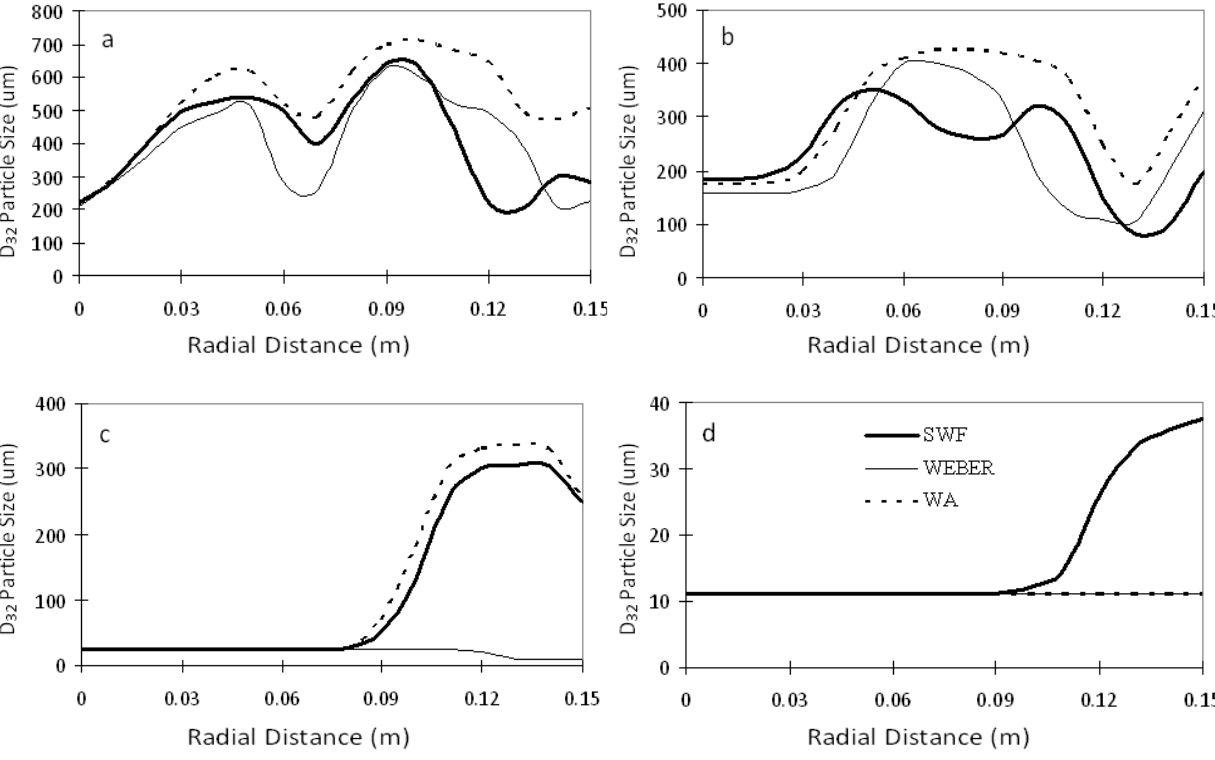
Figure 4. Predicted radial variation of the D ( b ) 100 psi (0.69 MPa); ( c ) 200 psi (1.38 mpa); ( d ) 300 psi (2.07